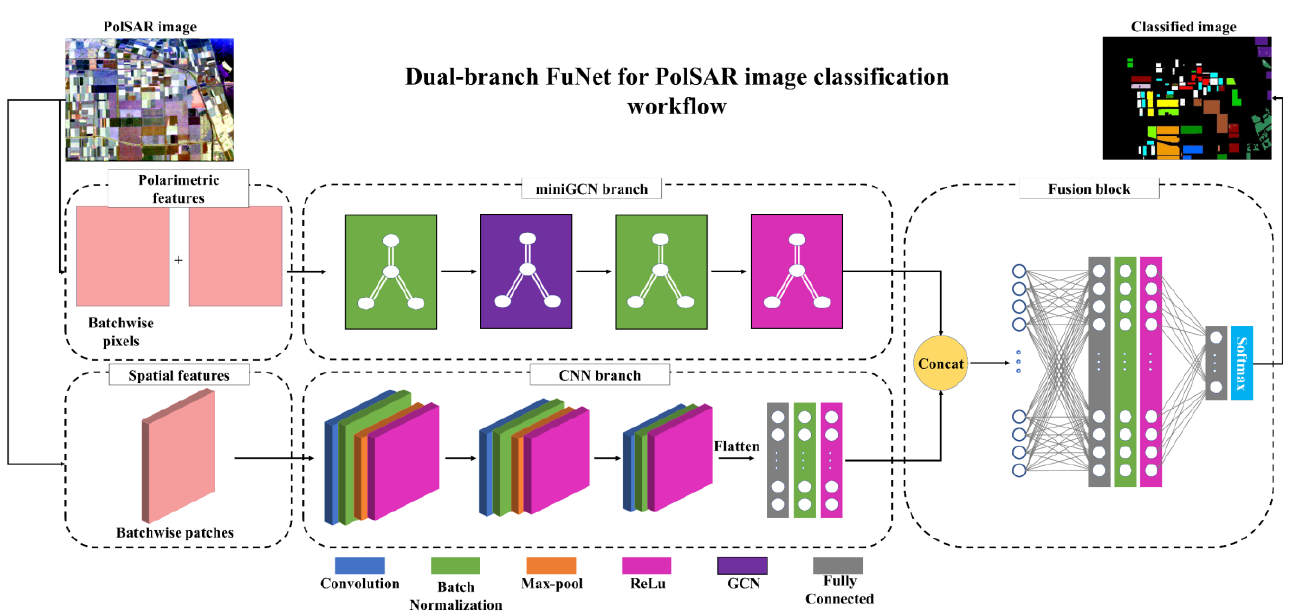
Figure 4. The framework of the proposed dual-branch FuNet, including three main steps: polarimetric and spatial feature extraction, miniGCN and CNN layers, and fusion layers leading to a classified PolSAR image.